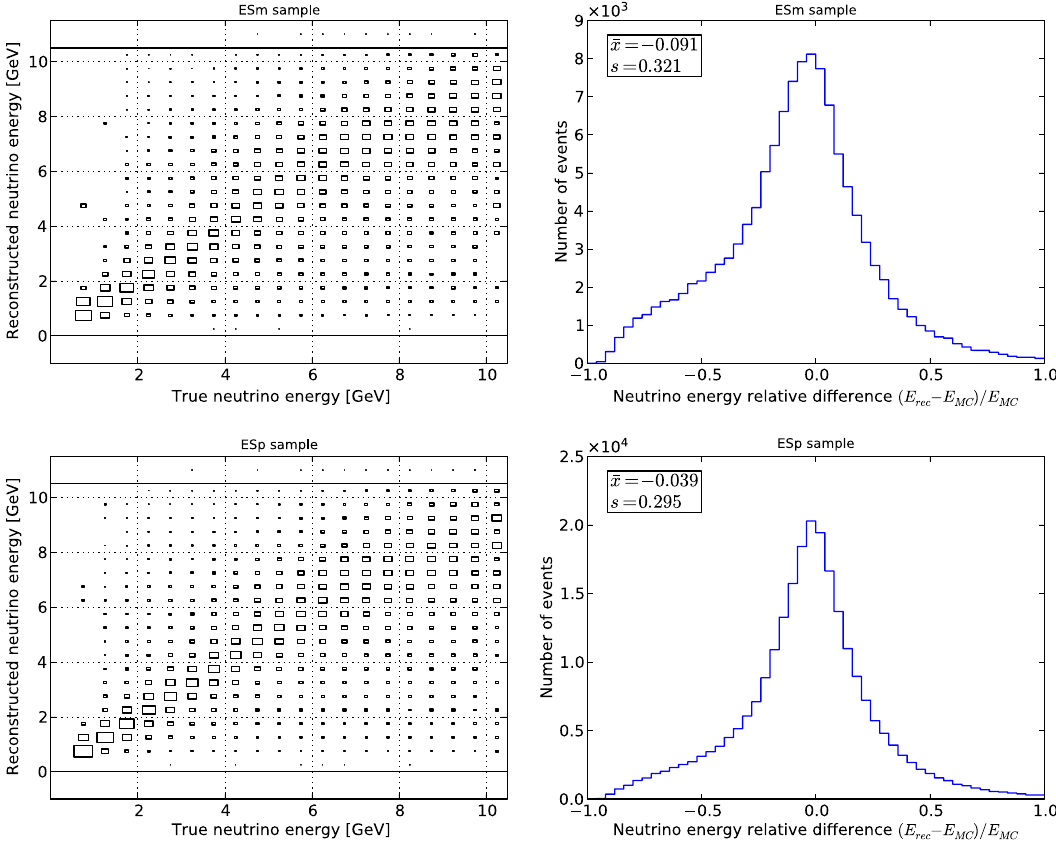
FIG. 16. Reconstruction of the neutrino energy using measured quantities. Left: Migration matrix (the sum over each column is normalizedtounity).Theoverflowandunderflowbinsareseparatedwithhorizontallines.Right:Relativedifference ð E meas (cid:5) (cid:1) E true (cid:5) Þ =E true (cid:5)